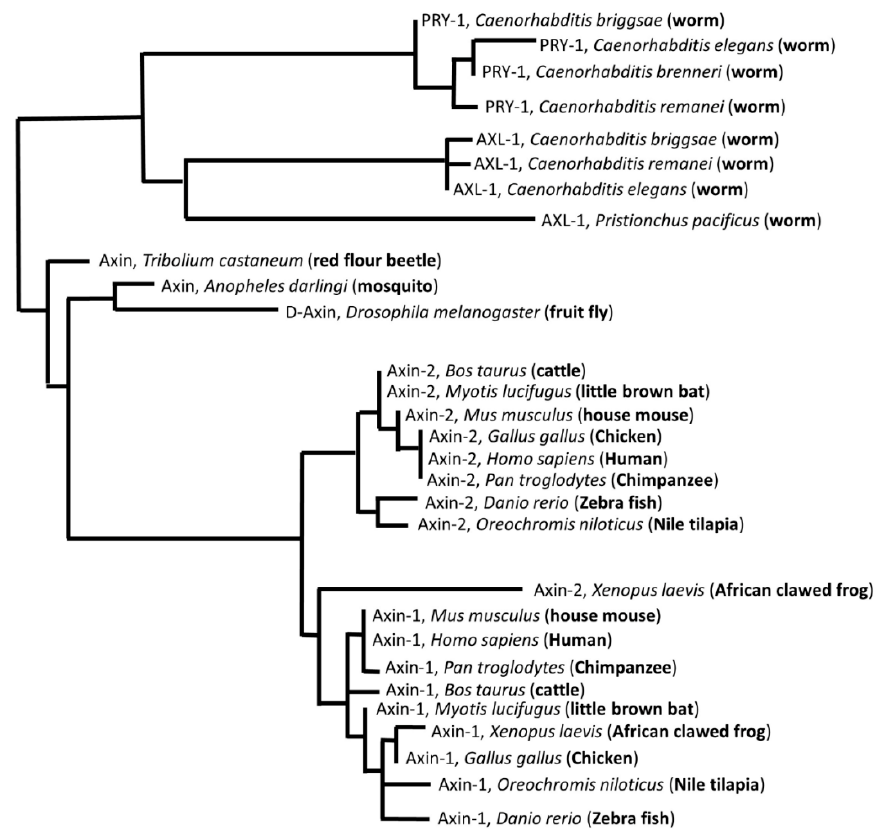
Figure 1. Axin family is conserved in multicellular eukaryotes. Multiple sequence alignment dendrogram was generated by LIRMM (http://www.phylogeny.fr/simple_phylogeny.cgi) using default program parameters.